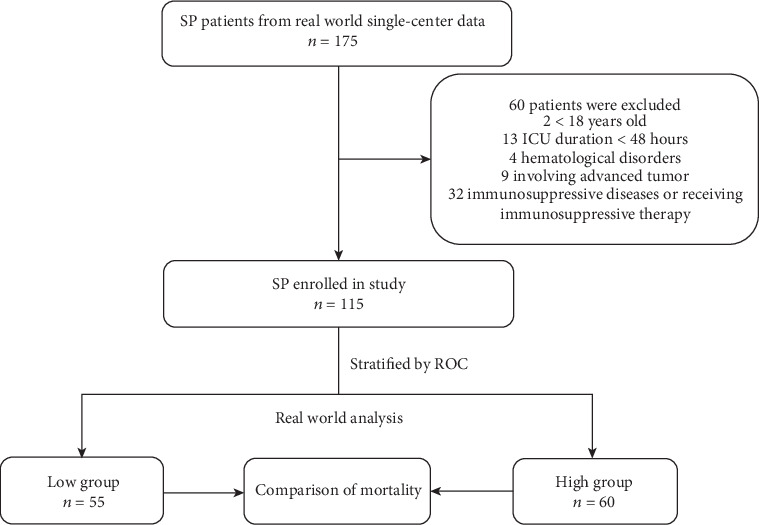
Study algorithm, including patient enrollment and outcomes. Note: low group: MPV ≤ 10.5; high group: MPV > 10.5. SP: severe pneumonia; ROC: receiver operating characteristic curve.